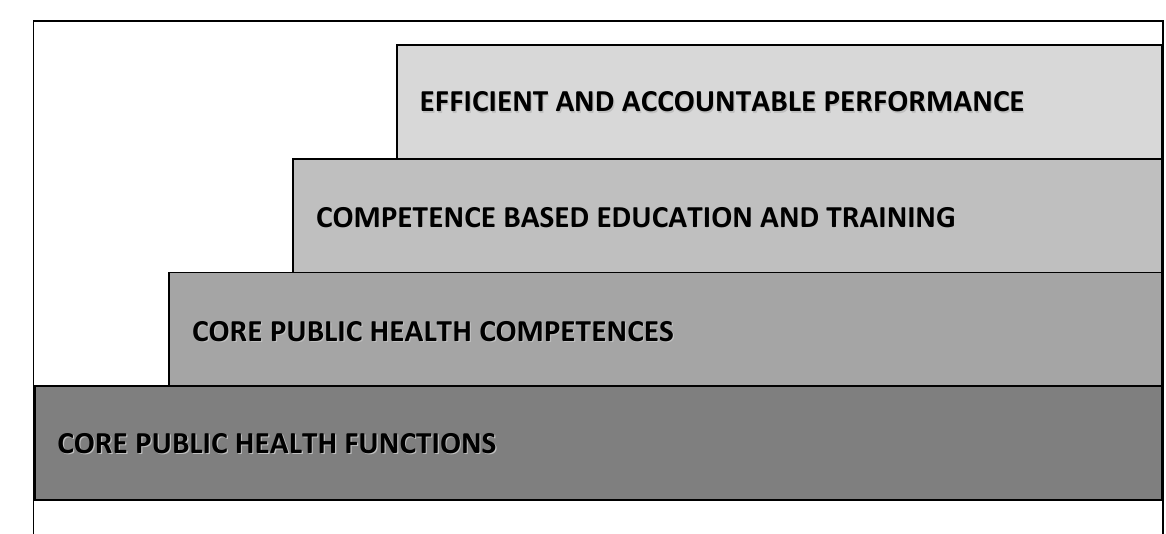
Figure 1. From core public health functions to core competences, teaching curricula and public health